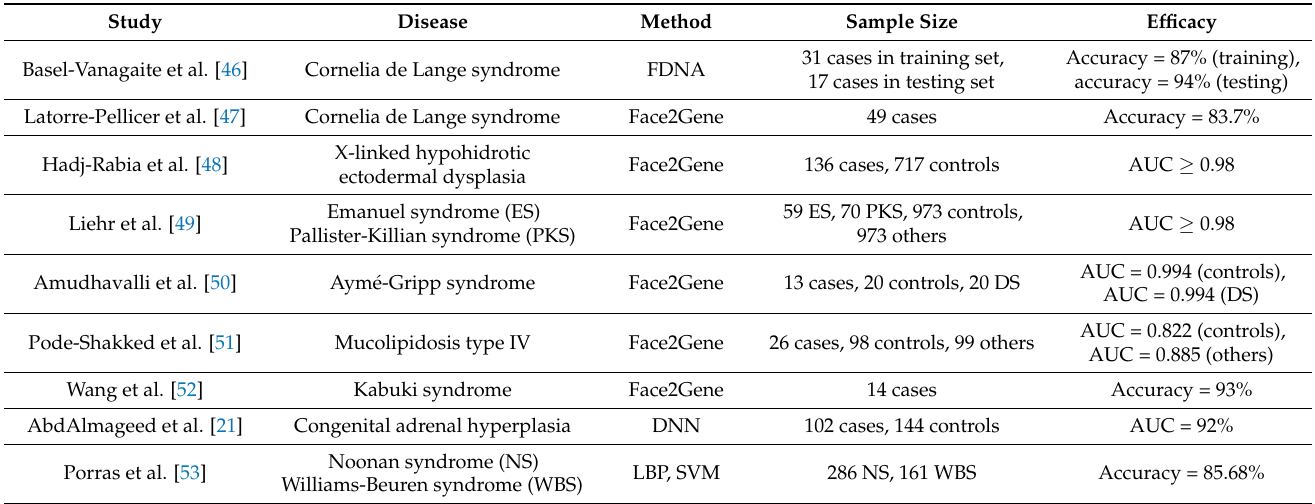
Table 2. Studies of facial-recognition-based diagnosis system for genetic